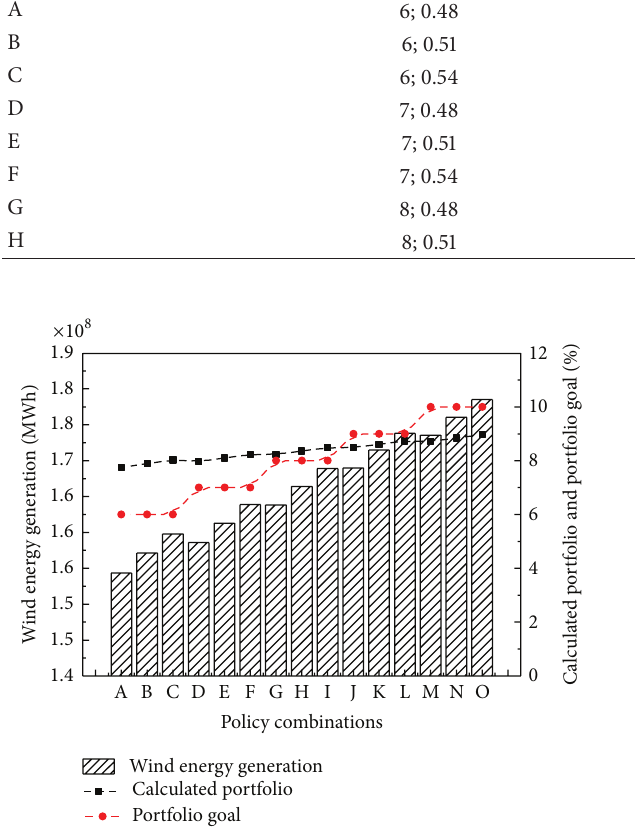
Figure 3: The wind energy generation, calculated portfolio, and portfolio goal of each policy combination.